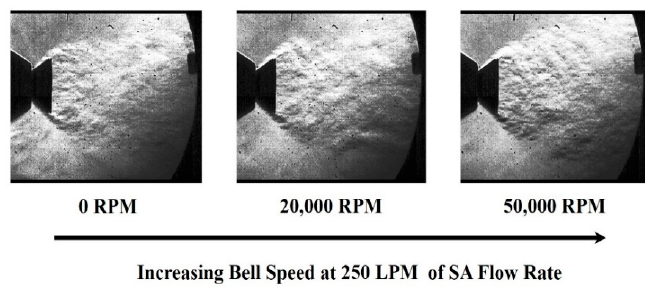
Figure 9. Schlieren image of the ERBS SA, showing changing bell cup rotational speed at a fixed SA flow rate of 250 LPM.